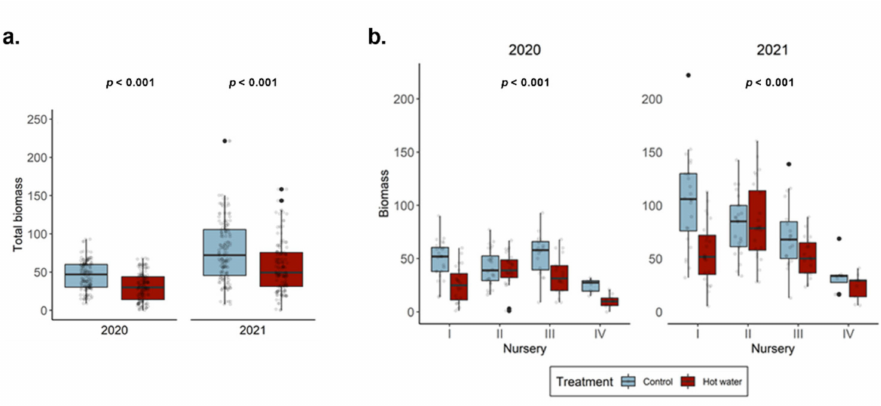
Figure 1. ( a ) Total accumulated biomass (g) of control and hot water-treated plants at planting (2020) and at harvest (2021) and ( b ) biomass analyzed by nursery of